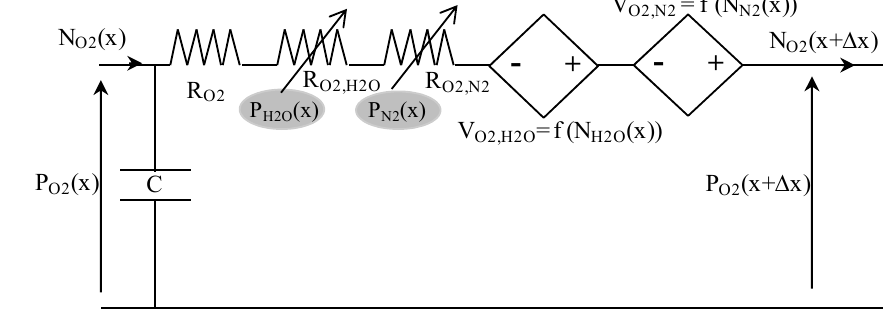
Figure 5. Equivalent electrical circuit for oxygen transport in cathode